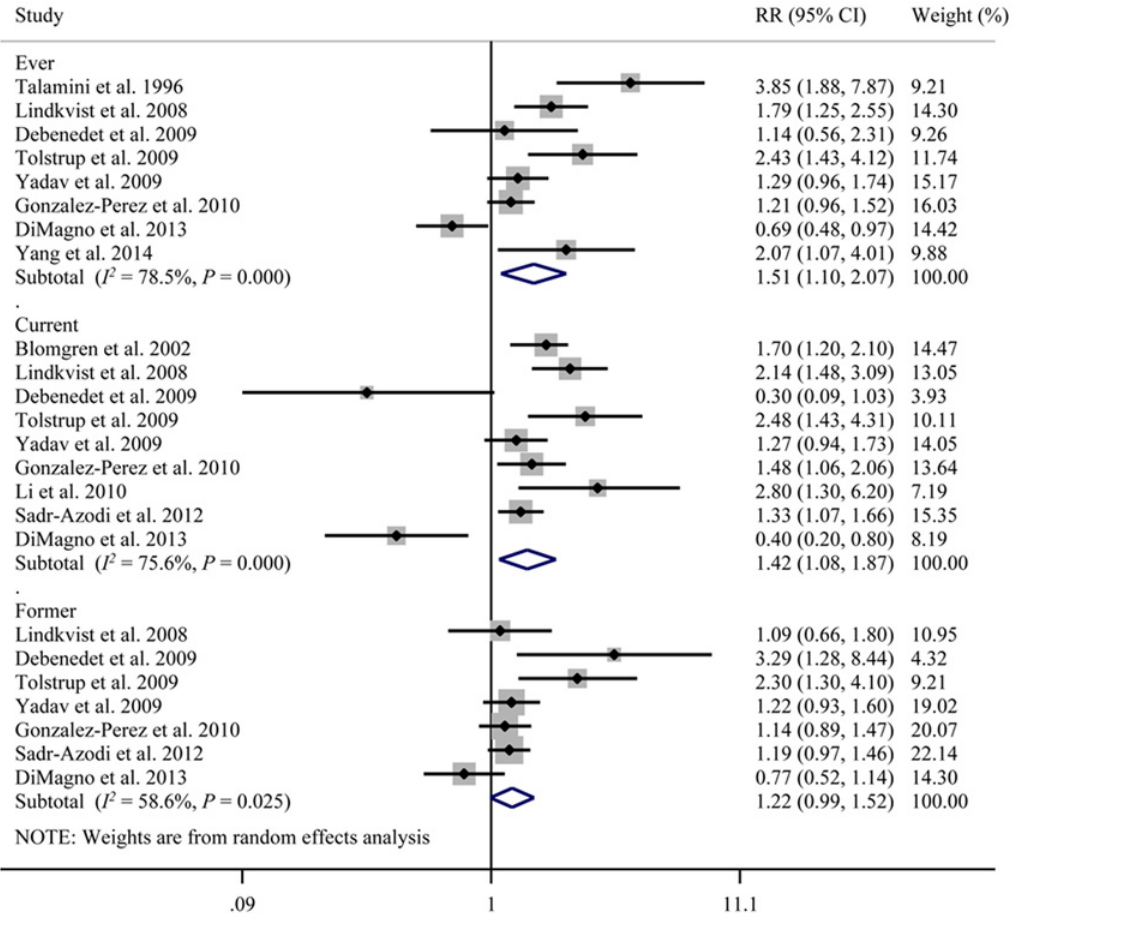
Fig 2. Cigarette smoking and the risk of acute pancreatitis. CI, confidence interval; RR, relative risk.